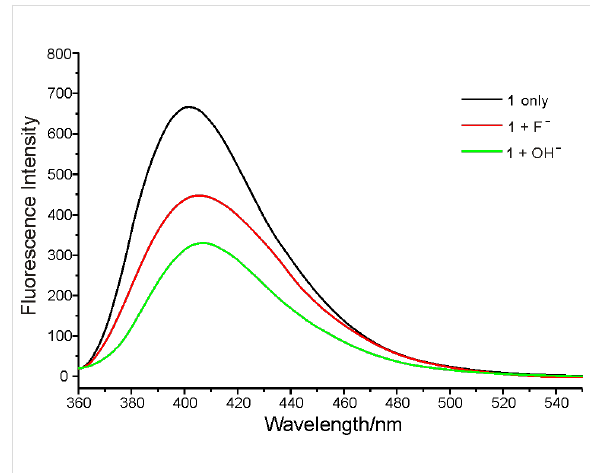
Figure 8: Fluorescence emission changes of 1 (5 μ M) upon the add- ition of F − and OH − (5 equiv) in CH 3 CN (excited at 340